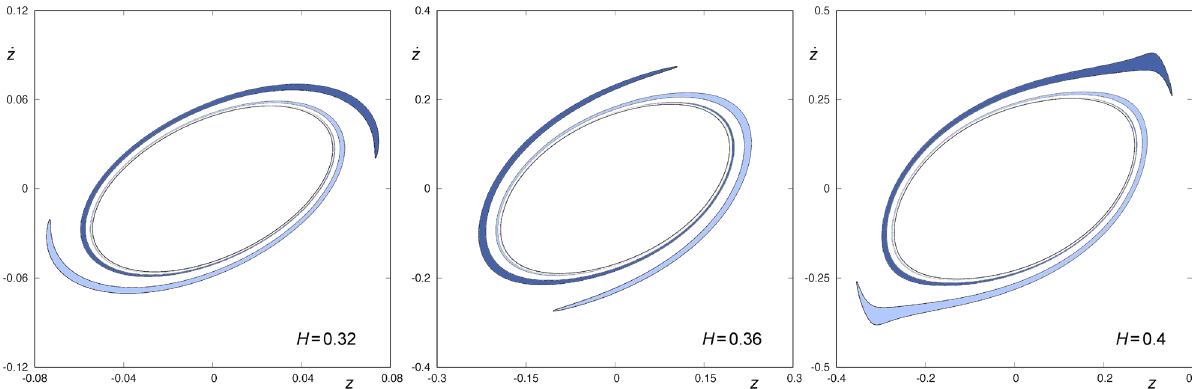
Figure 4. W s ,4 (φ) for H = 0.32, 0.36 and 0.4 (from left to right, respectively). The area enclosed by W s ,4 (φ) is colored in blue. The two infinite tongues colored in light and dark blue are the result of the backward integration of the tongues colored in the same shade of blue in Fig. 3. This graphic has been generated by using Gnuplot Version 5.2. http:// www. gnupl ot.